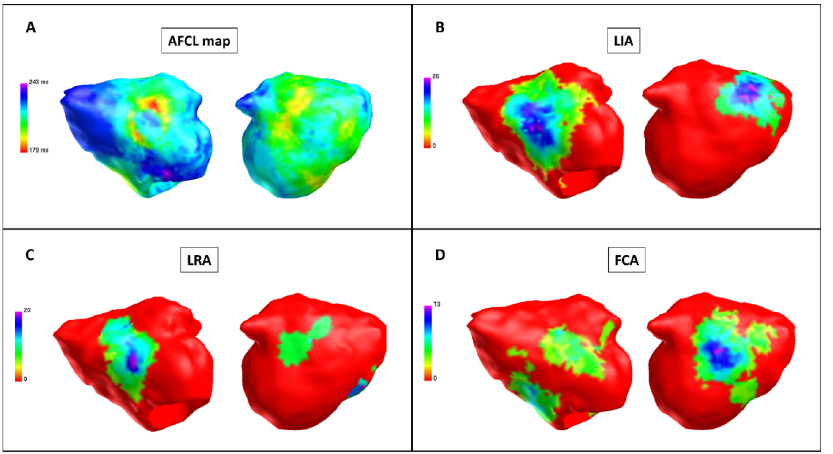
Figure 2. Charge density map after pulmonary vein isolation (Patient 9). Charge density map with the AcQmap TM catheter. Each color point on the map corresponds to the color-matched legend on the left. ( Panel A ) Atrial fibrillation cycle length (AFCL) map: left side, anterior-posterior view; right side, posterior-anterior view. When compared with baseline, the AFCL is higher in the posterior region; there is no area of a short AFCL in the anterior region. Color bar describes AFCL in ms. ( Panel B ) LIA map: left side, anterior-posterior view; right side, posterior-anterior view. Higher LIA number in the anterior and posterior regions. Color bar describes LIA in LIA/s. ( Panel C ) LRA map: left side, anterior-posterior view; right side, posterior-anterior view. Higher LRA number in the anterior and posterior regions. Color bar describes LRA in LRA/s. ( Panel D ) FCA map: left side, anterior-posterior view; right side, posterior-anterior view. Higher FCA number in the anterior and posterior regions. Color bar describes FCA in FCA/s. FCA: focal centrifugal activation; LIA: localized irregular activation; LRA: localized rotational activation.